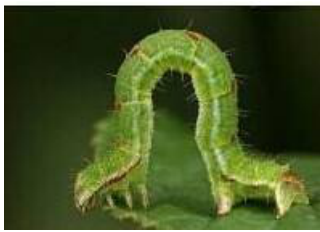
Figure 1. Inchworm creeping scene.